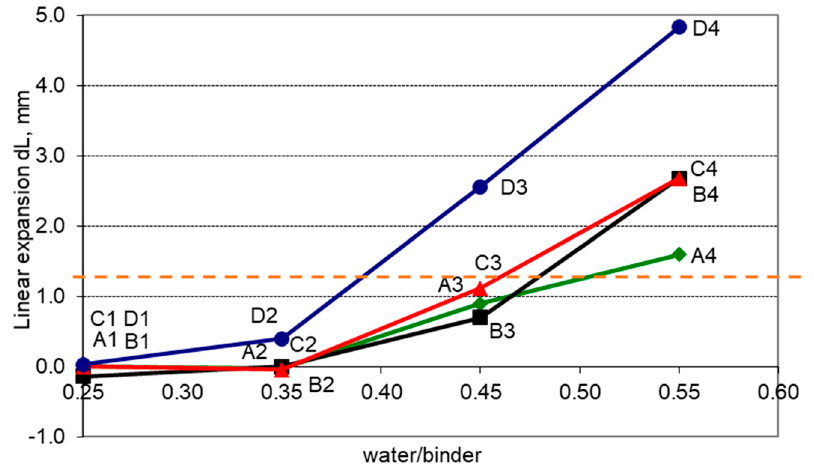
Figure 9. Influence of w/b ratio and GGBS content on specimen linear expansion dL.